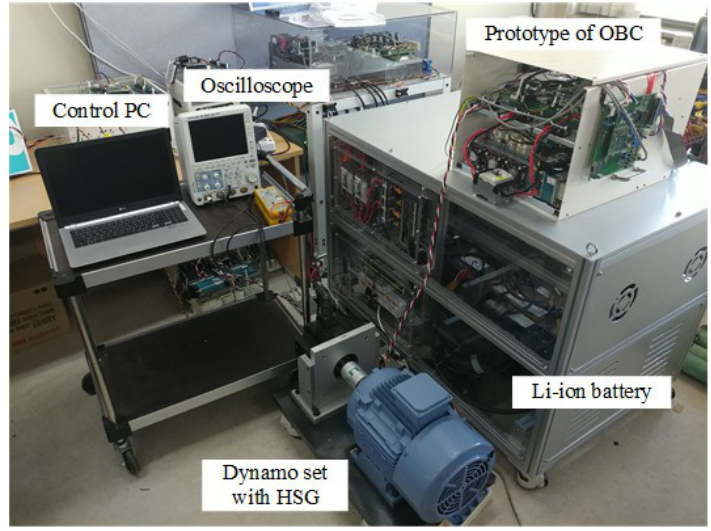
Figure 12. Construction of the experiment hardware set.